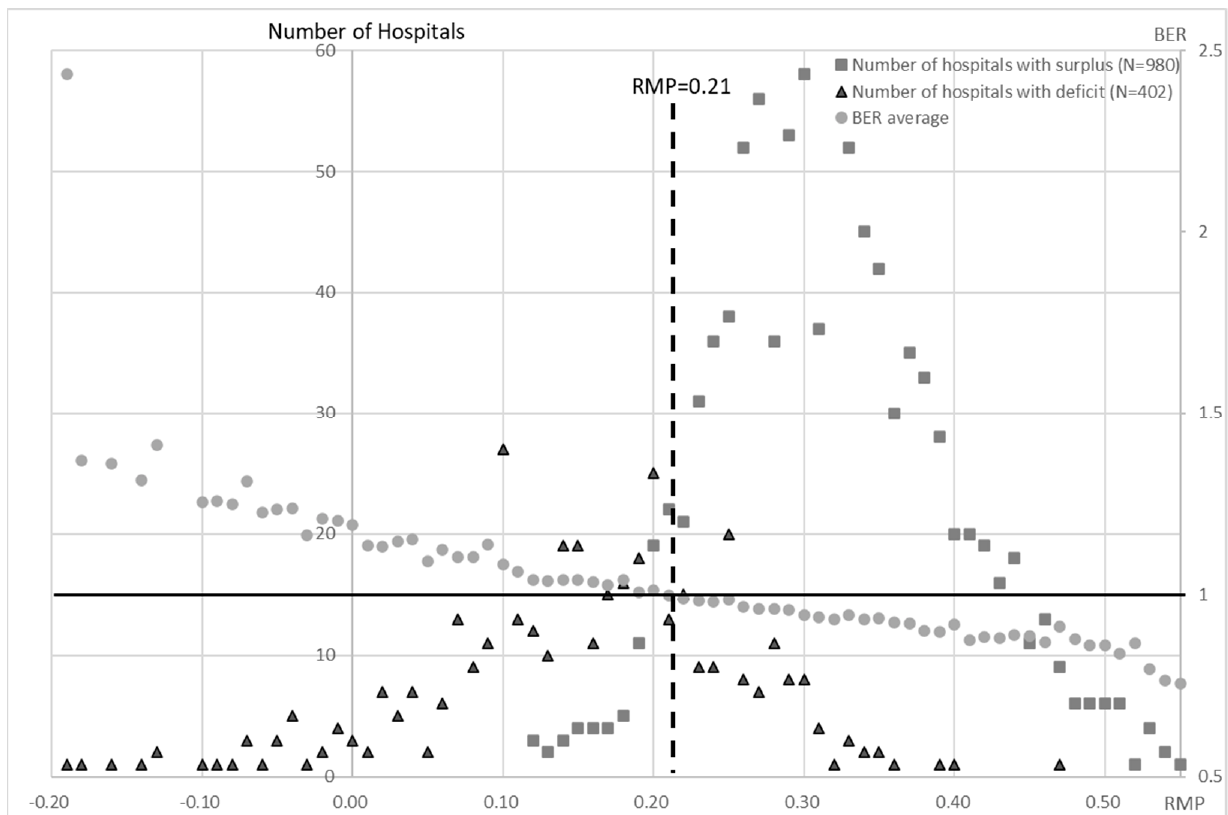
Figure 9. Calculation of BER for each RMP in groups 4, 5, and 6 for all 15 years. The number of deficit and surplus hospitals for all years was disaggregated by RMP value. The BER shows the average of all hospitals with each RMP value. Most surplus hospitals were located above RMP = 0.25, while most deficit hospitals were located below 0.21. On the other hand, the average BER crosses the line of RMP = 0.21 between surplus and deficit hospitals. This indicates that RMP = 0.21 is a critical point in terms of management.